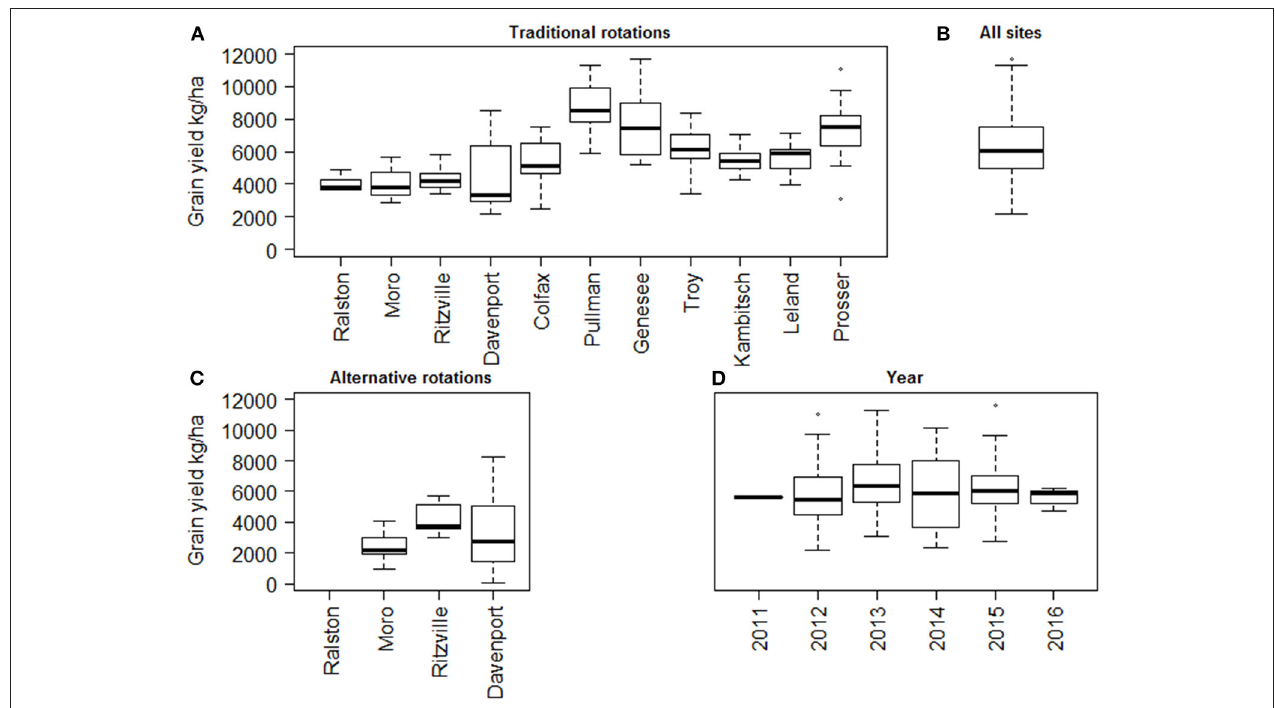
FIGURE 1 | Variance in winter wheat yields in (A) traditional rotations among the sites (ordered by increasing in long term mean annual precipitation of crop season), (B) across all site locations and year, (C) alternative rotations among the sites receiving < 350mm annual precipitation yr − 1 , and (D) by year. The Prosser location received